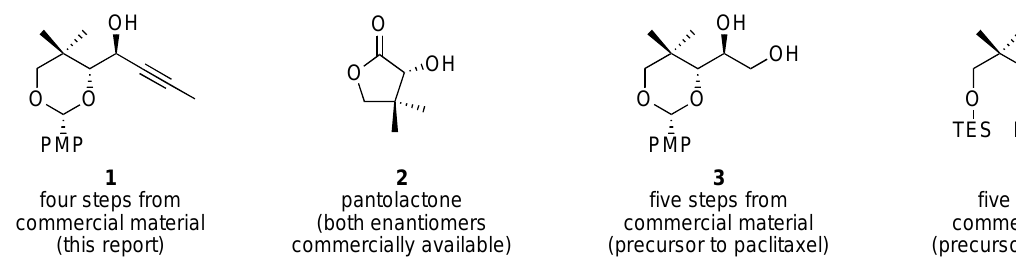
Figure 1. Chiral, functionally rich small molecule building blocks for chemical synthesis.